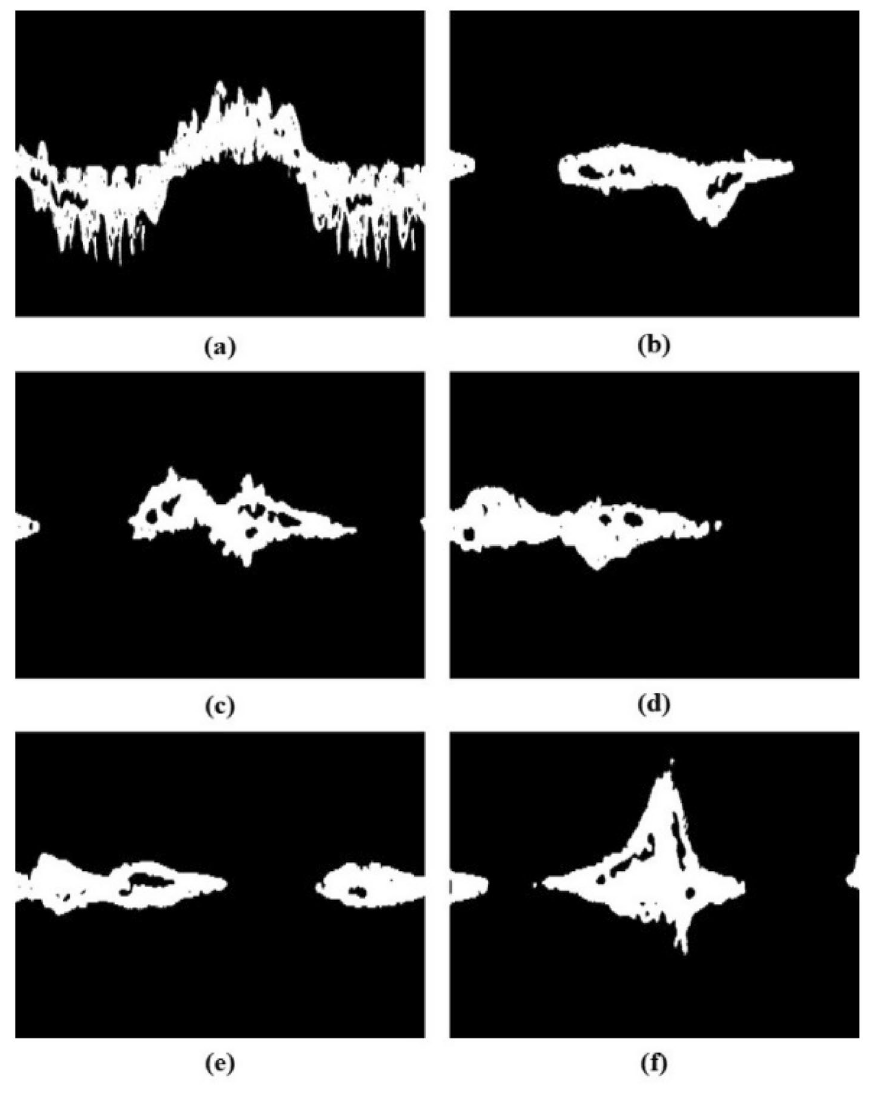
Figure 3. The binary mask of typical samples of the dataset. ( a – f ) represent activities A1 ~ A6 micro-Doppler spectrograms.